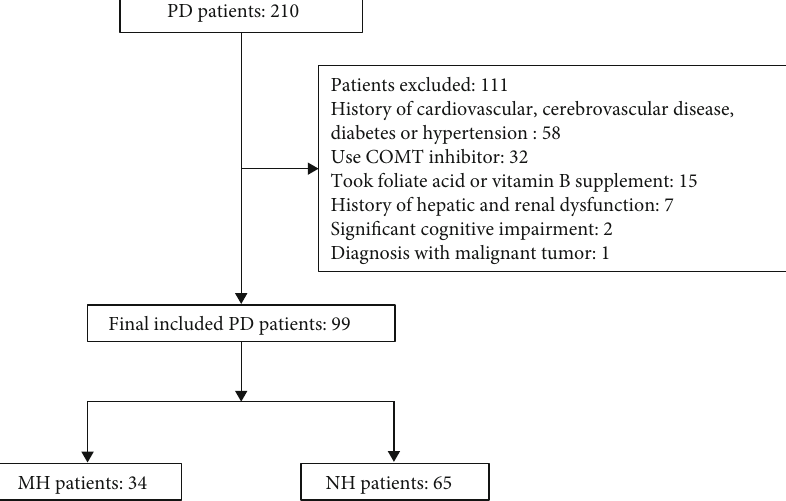
Figure 2: Study fl ow chart. PD: Parkinson ’ s disease; COMT: catechol-O-methyltransferase; MH: minor hallucination; NH: no